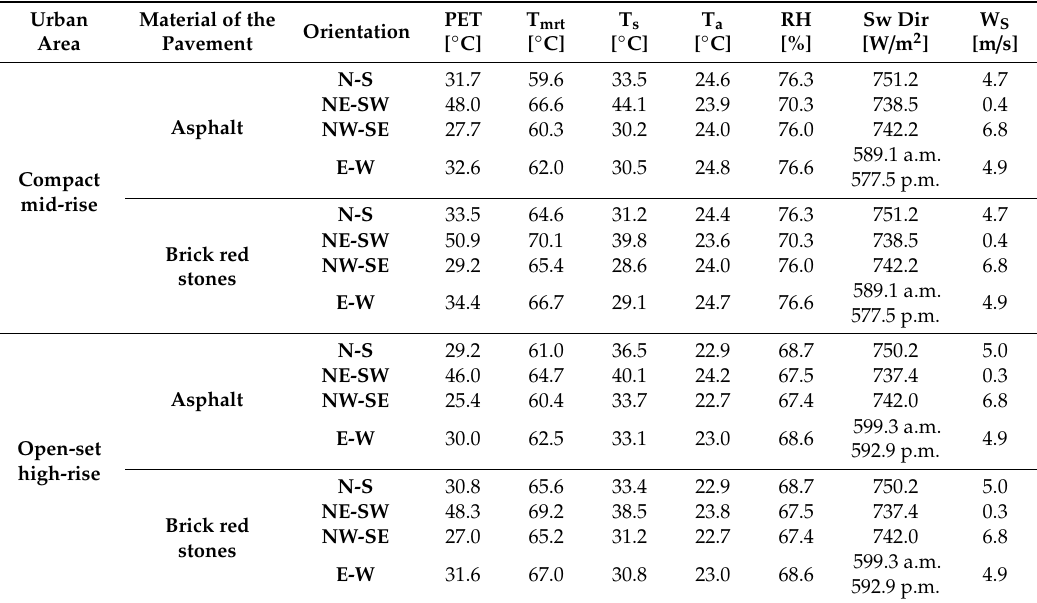
Table 12. Peak values of PET, T s , T mrt , T a , RH and W s for all orientations with asphalt and red brick stones in compact mid-rise and open set high-rise urban canyons.